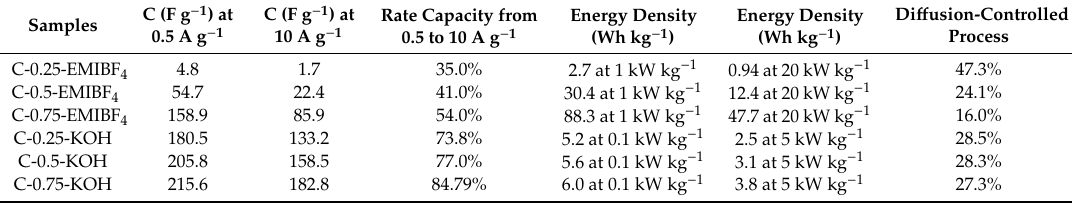
Table 2. A summary of the key performance parameters, such as the specific capacitance, rate capacity, energy–power density, and contribution of the di ff usion-controlled process in both electrolytes.